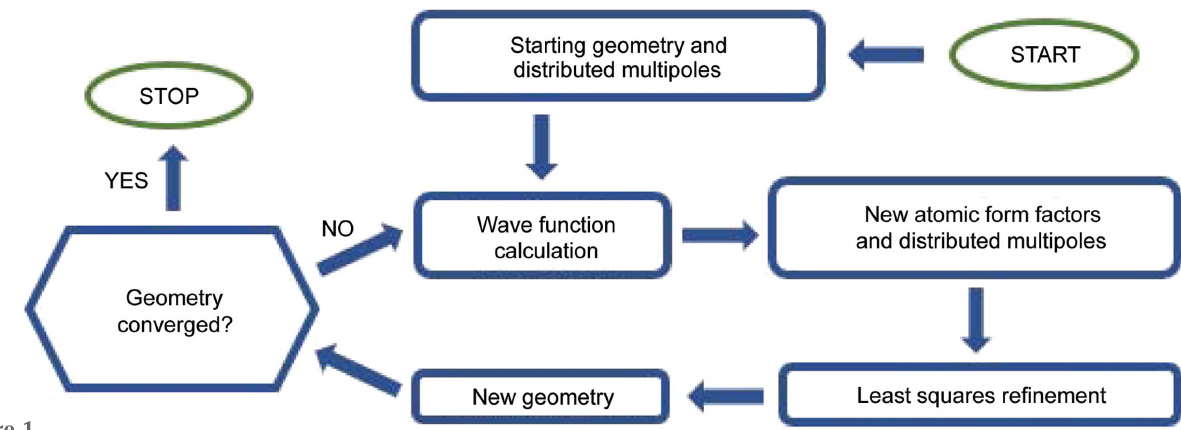
Figure 1 HAR algorithm